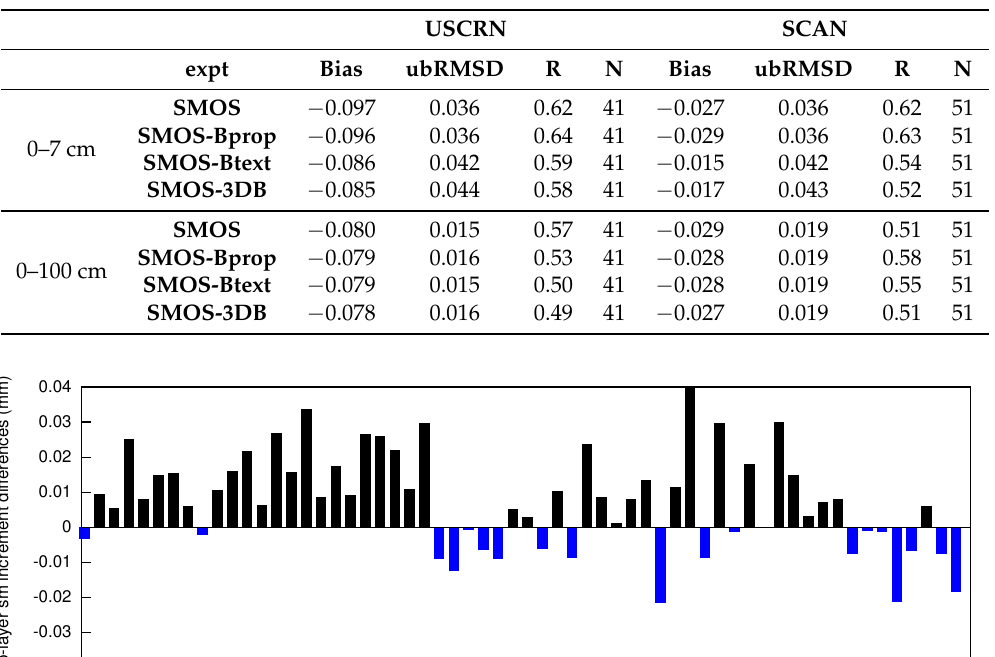
Table 4. The same as Table 2 but in this table the performance of the analyses with different definitions of the B matrix is studied: in SMOS , the B matrix is fixed, whereas in SMOS-Bprop it is propagated in time until the next cycle. SMOS-Btext and SMOS-3DB introduce the information of soil texture in the background error while keeping their value fixed along the assimilation window.